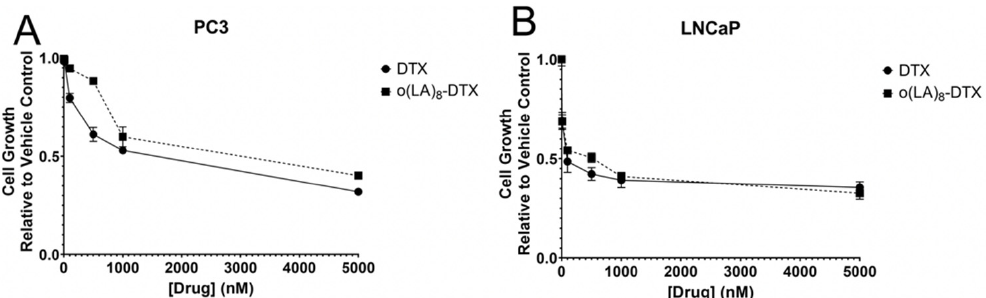
Figure 5. In vitro cytotoxicity of o(LA) 8 -DTX relative to parent drug DTX in ( A ) PC3 and ( B ) LNCaP prostate cancer cells. Cells were incubated with drug-treated media for 48 h (n = 3; mean ± standard error of the mean (SEM)).